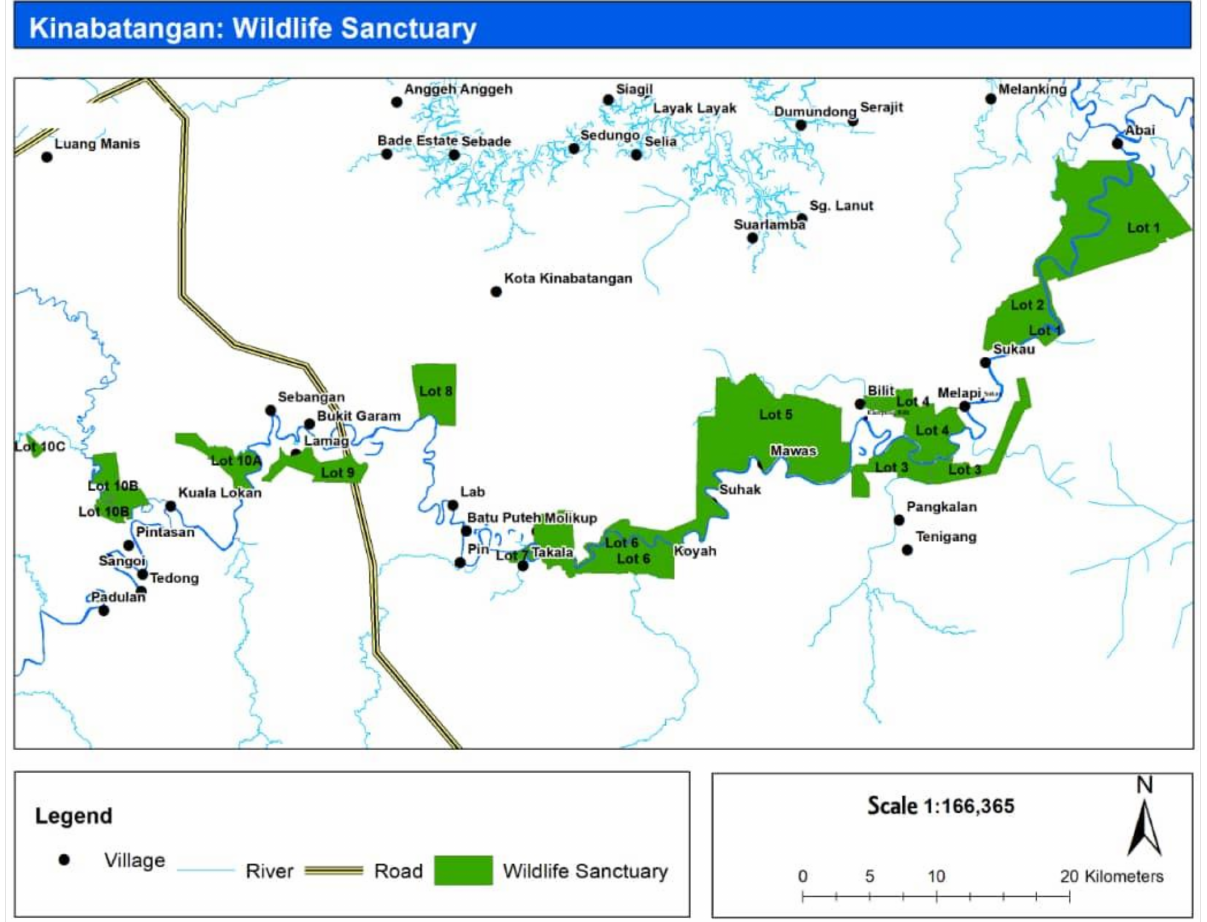
Figure 2. Ten lots (green) as Lower Kinabatangan Wildlife